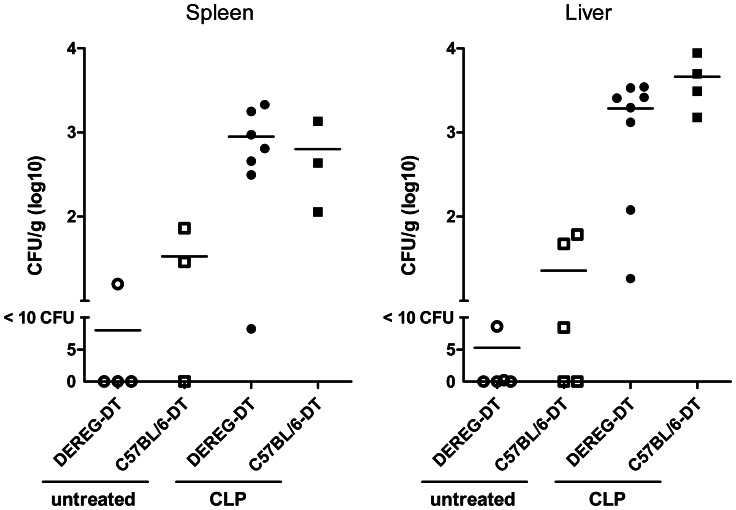
No influence of Treg depletion on bacterial dissemination in CLP-treated mice.DEREG and C57BL/6 mice pre-treated with DT (1 µg in 100 µl PBS i.v. on days −2 and −1) were subjected to CLP (n = 3–7 mice/group) or left untreated (n = 3–5 mice/group). Liver and spleen were recovered from Treg-depleted and non-depleted mice 24 h after CLP. Tissue homogenates were incubated on Columbia blood agar for 22 h at 37°C. Colony-forming units (CFUs) were related to organ weight. Means are shown.